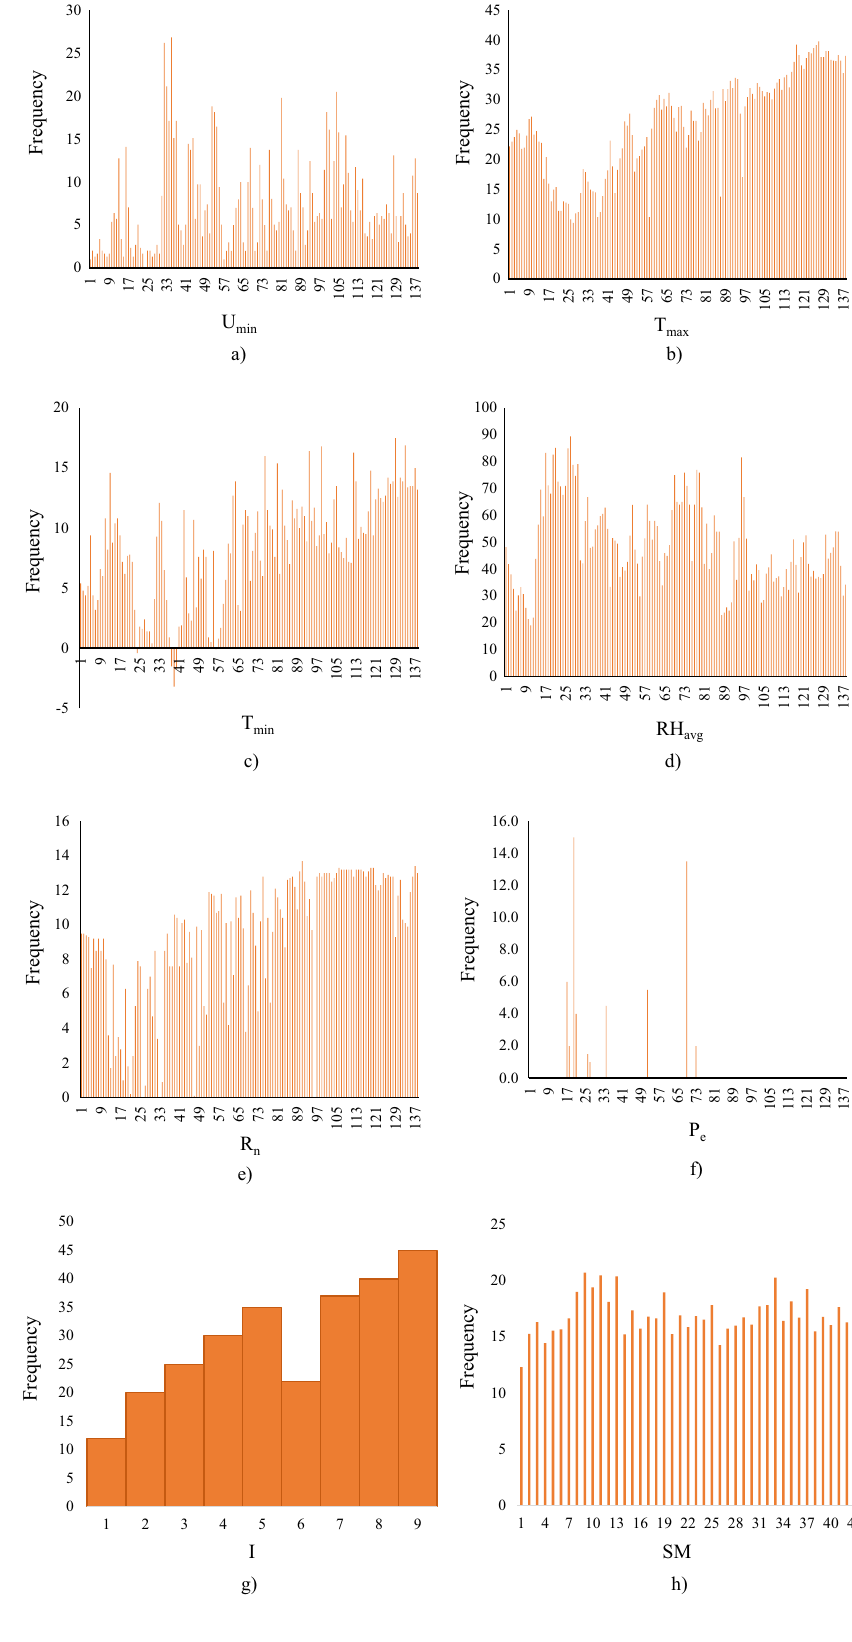
Fig. 6 a – h Histogram of input and output